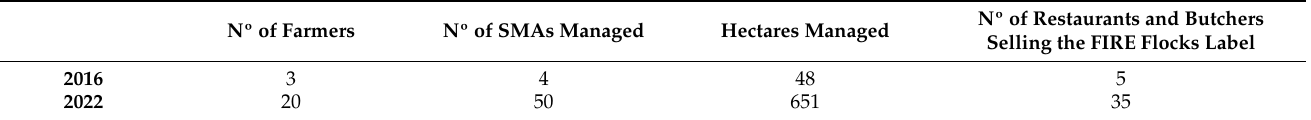
Table 1. Initial and current status of the Fire Flocks